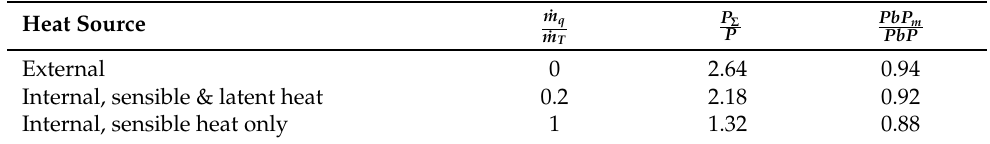
Figure 7. Four stage expansion process for a fixed turbine efficiency η x = ( 0.8,0.8,0.8,0.8 ) , refer to Case 1 in Table 1. Table 4. Generated electrical power P Σ and payback period PbP m of a multi-stage expansion for three P PbP different heat sources, the multi-stage data are normalised with their corresponding single-stage